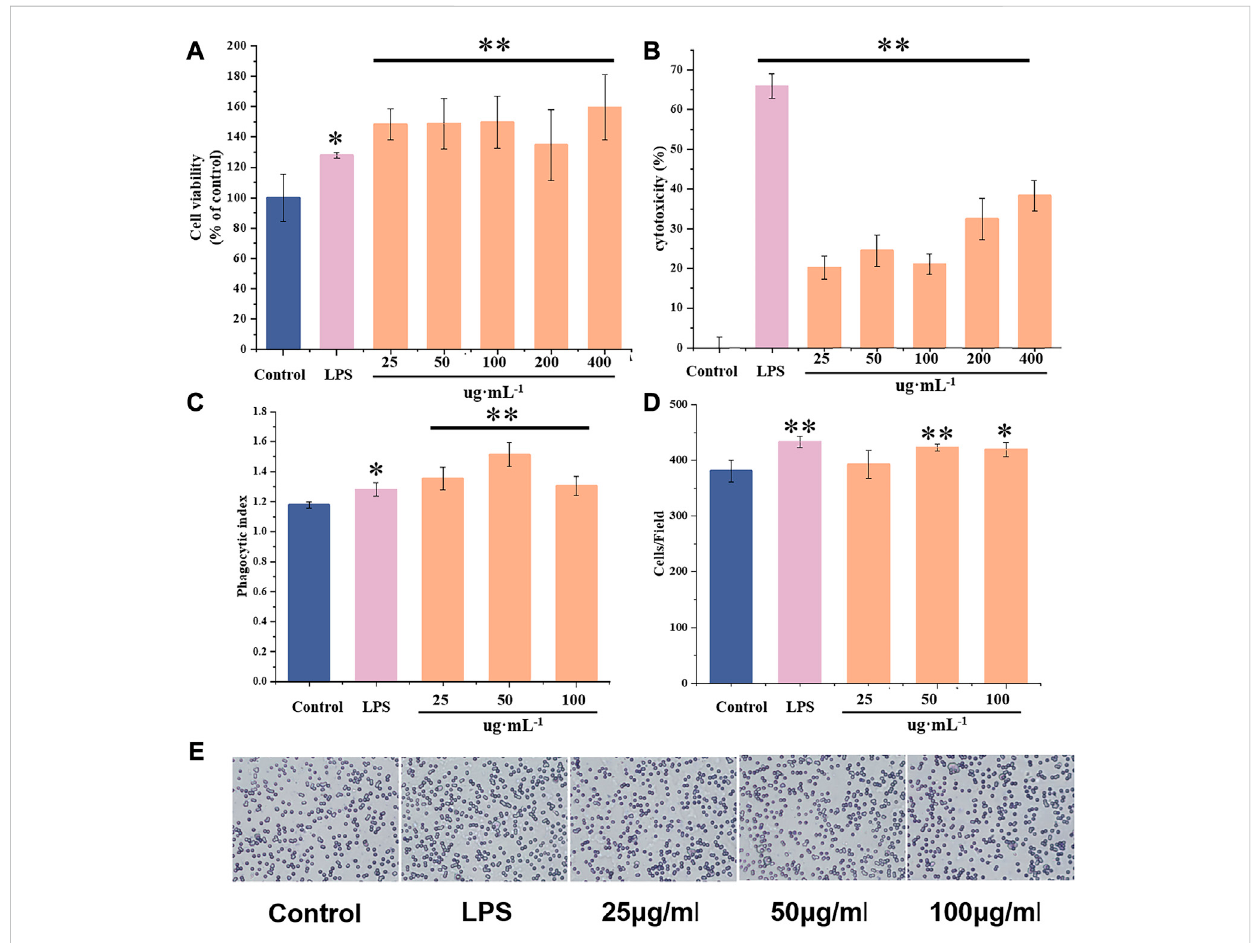
FIGURE 6 Effects of FNPS on the activity of RAW 264.7 cells (A) Effects of FNPS on the proliferation of RAW264.7 cells. (B) Cytotoxicity assay of FNPS in RAW264.7 cells. (C) Effects of FNPS on the phagocytosis of RAW264.7 cells. (D) Effects of FNPS on the migration of RAW264.7 cells, stained with crystal violet. (E) RepresentativeimagesofRAW264.7cellsmigrationtests.Note:Control,unadministeredcells;LPS,lipopolysaccharide* p < 0.05 versus Control, ** p < 0.01 versus